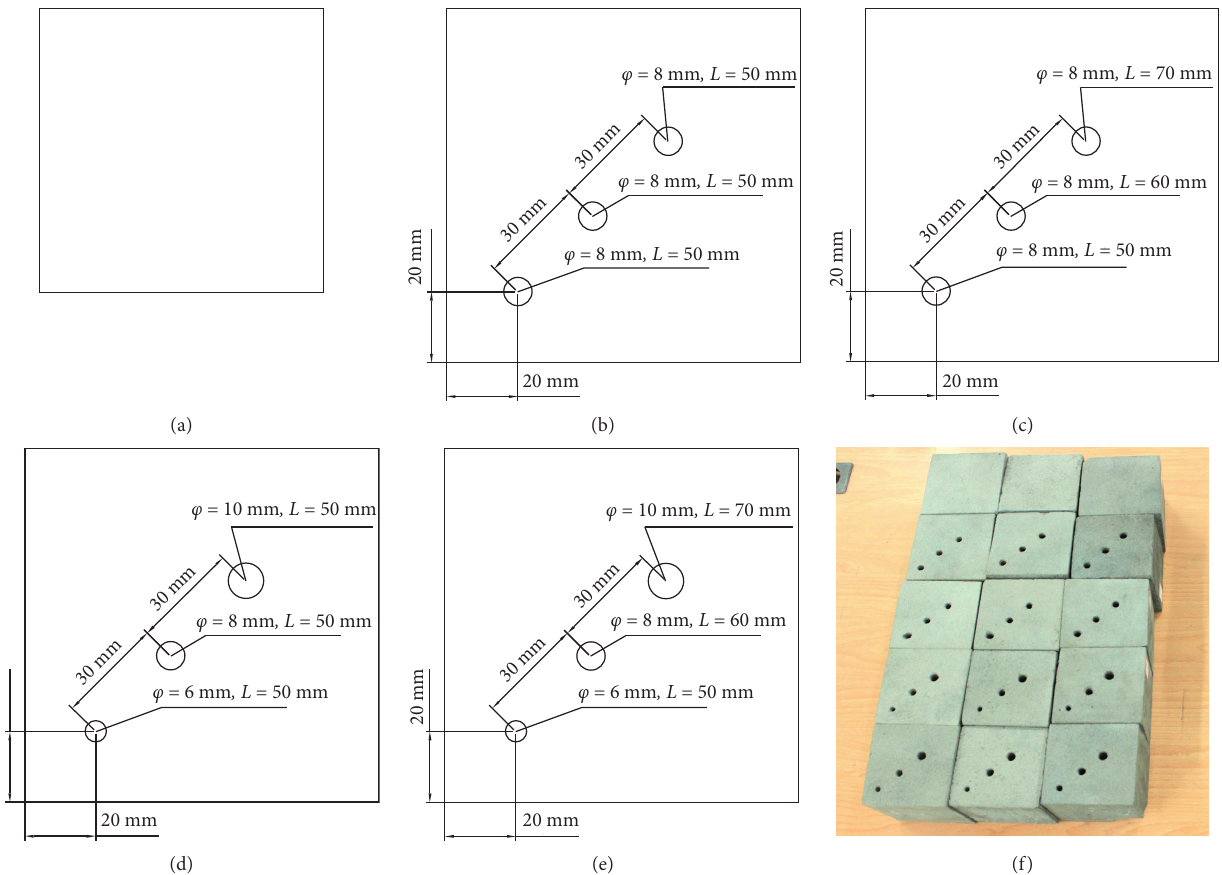
Figure 2: Sample layout of the borehole arrangement. (a) Scheme I: complete samples. (b) Scheme II: samples with boreholes. (c) Scheme III: samples with borehole with stepwise increased borehole depth. (d) Scheme IV: samples with borehole with stepwise increased borehole diameter. (e) Scheme V: samples with borehole with stepwise increased borehole depth and borehole diameter. (f) Part of the samples.